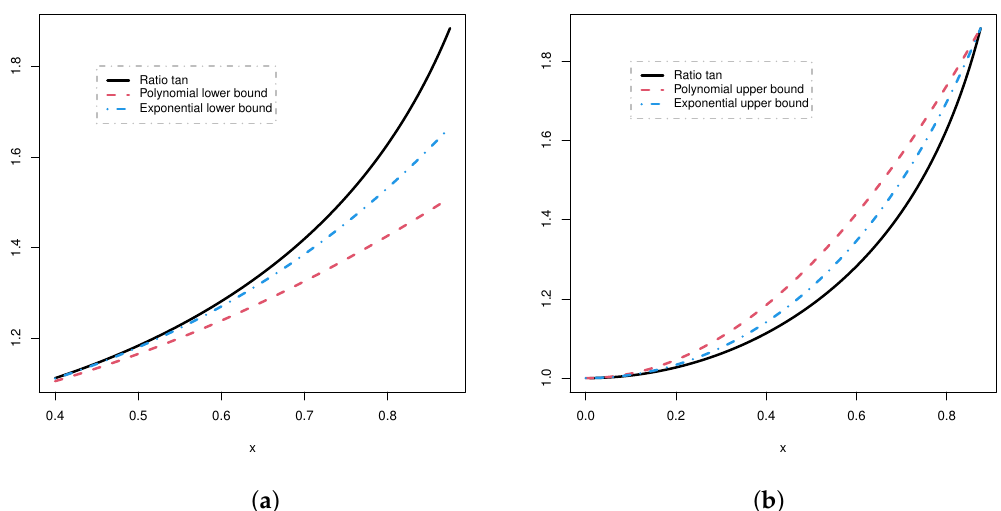
Figure 1. Visual comparison of the bounds for sin − 1 x per bounds for x ∈ [ 0,1 ] .